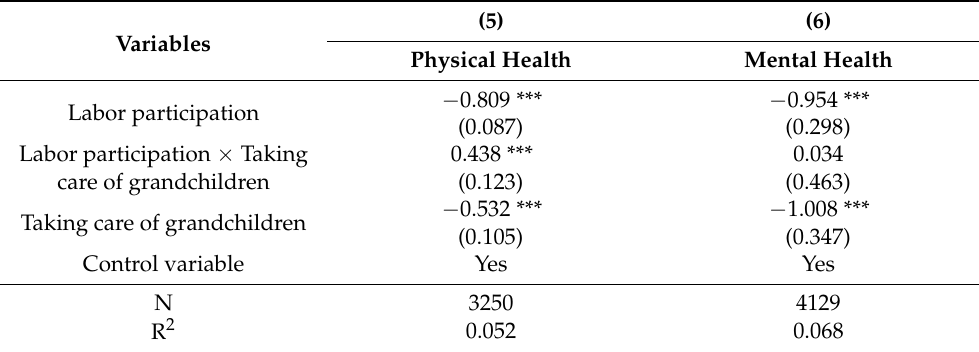
Table 5. Regression results of moderating effects (taking care of grandchildren was the moderating variable).